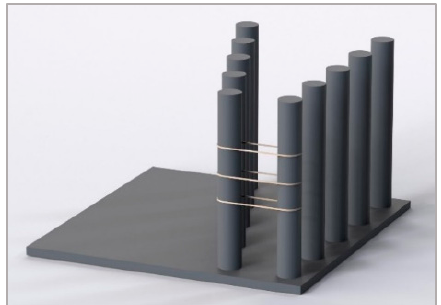
Figure 1. Elastic stretched to the exact distance on the force meter “ScienceCube” connected to the portable data logger “LabQuest3”.